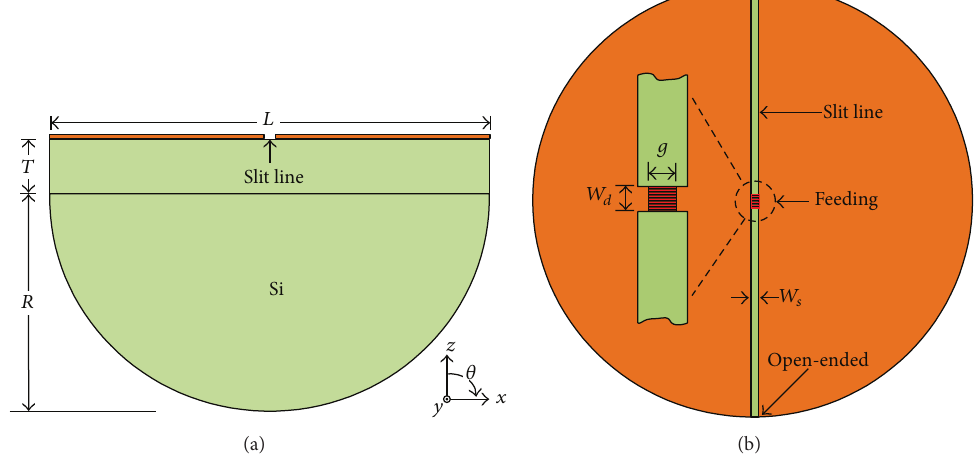
Figure 1: Antenna geometry: (a) side view and (b) top view.